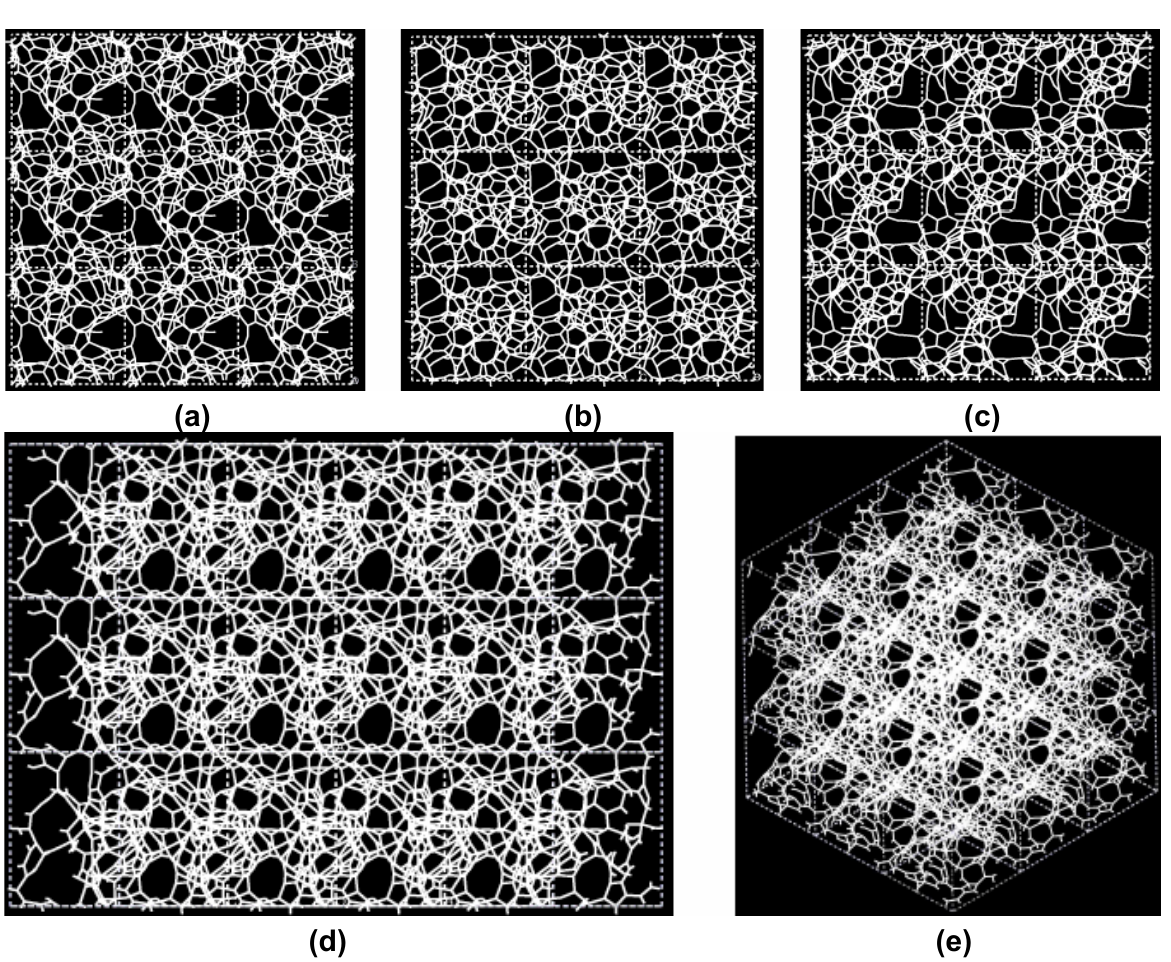
Figure 3. Pore structure obtained for 3 × 3 × 3 carbon cells. There are through pores in the (a) x and (c) z directions and smaller pores along the (b) y, (d) zy and (e) xyz